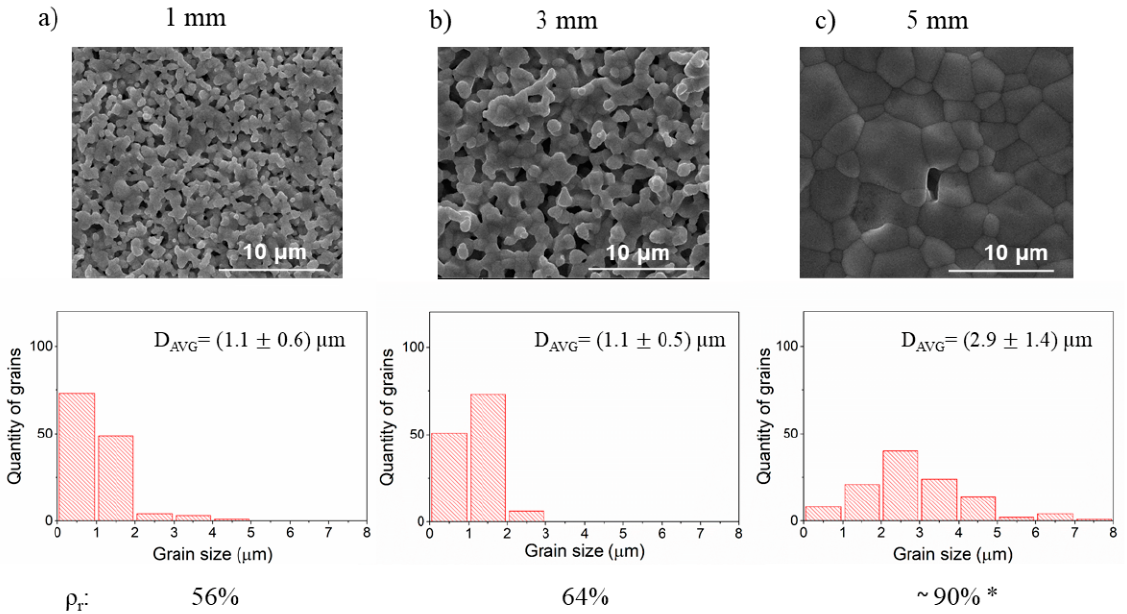
Figure 3. The SEM images of the BLCF ceramics obtained using balls of different diameters for the stage of reactants milling. Underneath each micrograph, an individual grain size distribution with corresponding relative density value ( ρ r ) is shown. ( a – c ). * The sample cracked during the density measurement, thus the result should be treated as an estimation. Table 4. Basic parameters of milling and characteristic energies of milling calculated according to [21,22]. D —diameter of milling ball, m —the mass of the ball, N —the number of balls, ω —angular velocity of milling disc, E imp —impact energy, f —frequency of hits, P —the power of milling, t tot —the total time when the disc was rotating during the milling process, E tot —total energy transferred during the